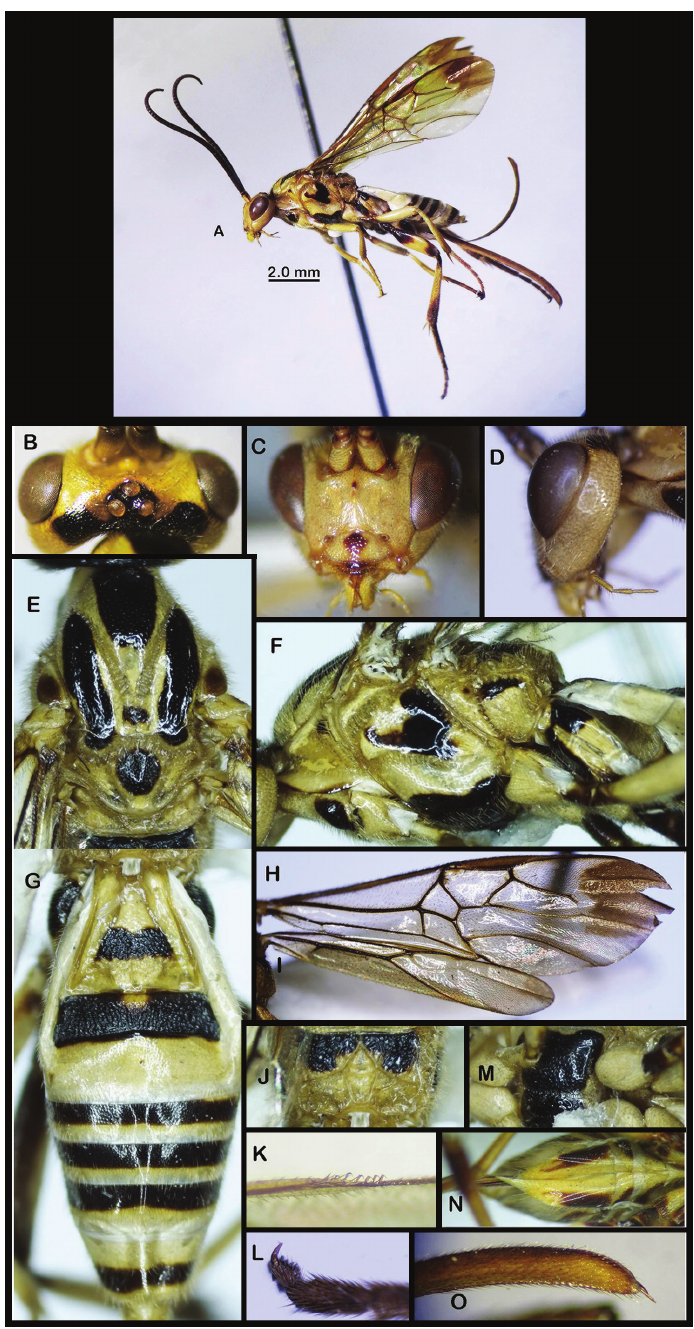
Figure 5. Orientocardiochiles nigrofasciatus sp. nov. A Lateral habitus (holotype, female) B head (dorsal view) C head (anterior view) D head (lateral view) E dorsal mesonotum F lateral mesonotum G meta- soma (dorsal view) H forewing I hind wing J propodeum K hamuli on hind wing L hind tarsal claw M ventro-lateral mesonotum N ventral metasoma O apex of ovipositor sheath (lateral